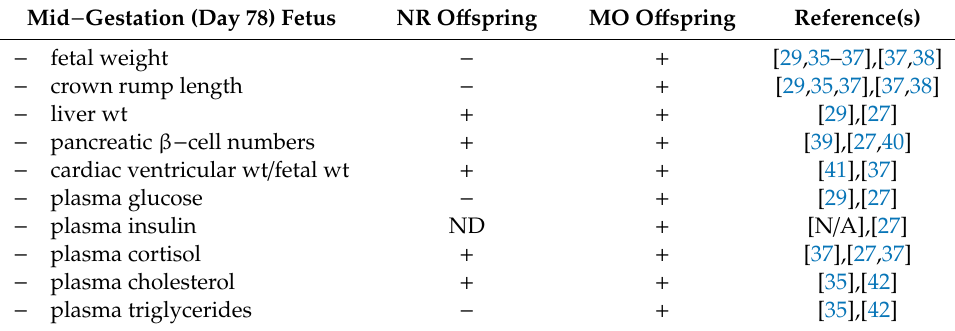
Table 1. Comparison of fetal and adult o ff spring characteristics of nutrient restricted (NR) and overfed-obese (MO) to ewes fed to